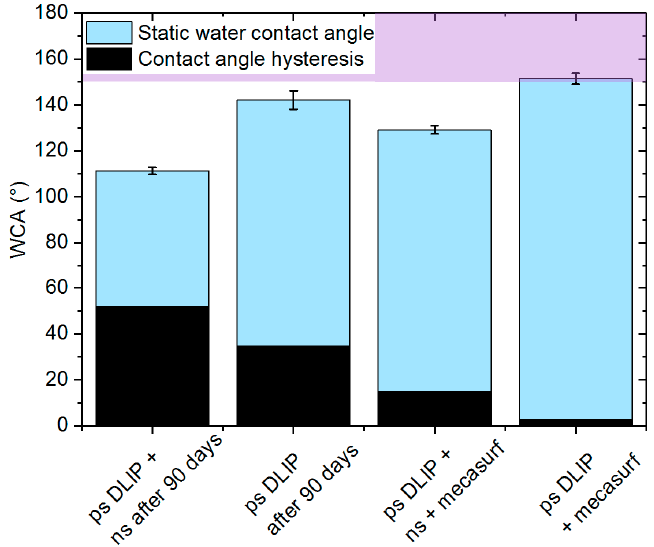
Figure 7. Static water contact angle (SWCA) and contact angle hysteresis (CAH) on the multi-scale (ps-DLIP) and single-scale structures (ps-DLIP + ns) measured 90 days after the laser treatment. New surfaces with the same topographies were treated with a hydrophobizing agent, permitting the multi-scale structures (ps-DLIP + mecasurf) to achieve superhydrophobic behavior. The values are an average of four SWCA measurements, the error bars were estimated by their standard deviation.